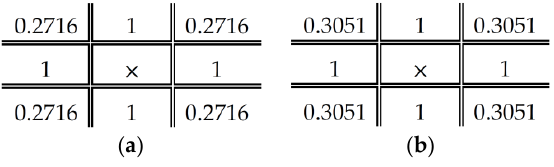
Figure 6. DDBTC diffused kernel for image block size: ( a ) 4 × 4 ; and ( b ) 8 × 8 .